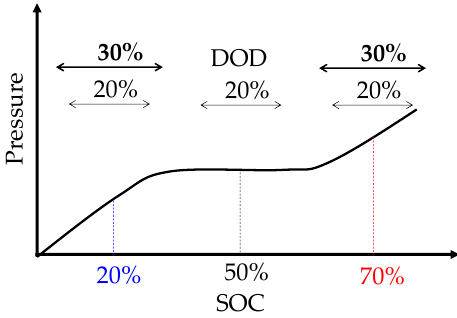
Figure 2. Schematic of the pressure evolution over the SOC of lithium-ion cells with graphite anode along with the average SOC and DOD selected for the cycling tests.